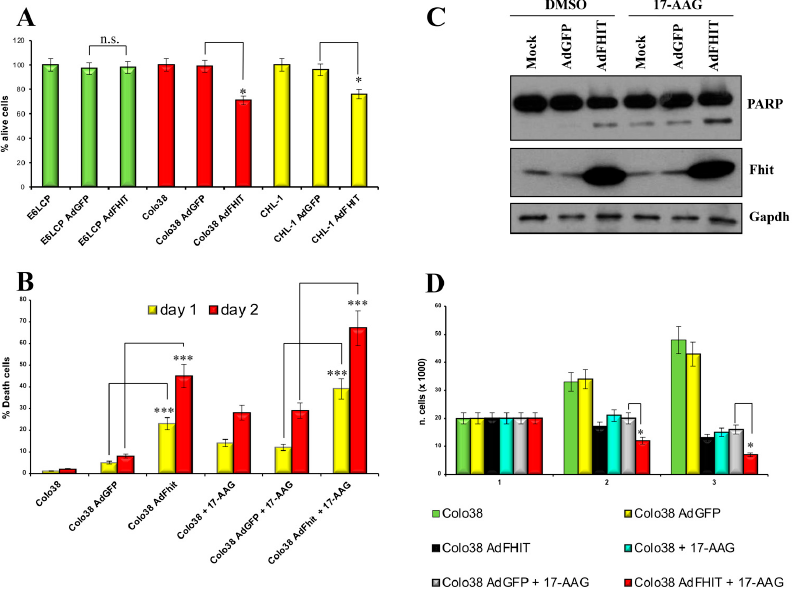
Figure 3. Restoration of Fhit expression reduces cell proliferation and induces apoptosis in human melanoma. ( A ) E6LCP, Colo38 and CHL1, Ad GFP , Ad FHIT, or mock-infected cells were analyzed using MTS assays (Student’s t -test, * p < 0.05; n.s., not significant). ( B ) Colo38 Ad FHIT and Ad GFP, untreated or treated with 17-AAG at 2 μ M, were analyzed using a TUNEL assay (one-way ANOVA, *** p < 0.001). ( C ) Cell lysates from the experiment described in B were blotted with antibodies against Fhit, Parp, and Gapdh. ( D ) Colo38 Ad GFP , Ad FHIT, or mock-infected cells, untreated or treated with 17-AAG at 2 μ M, were counted, and cell growth curves were calculated. Results show means ± SD from 3 independent experiments (Student’s t -test, * p < 0.05).